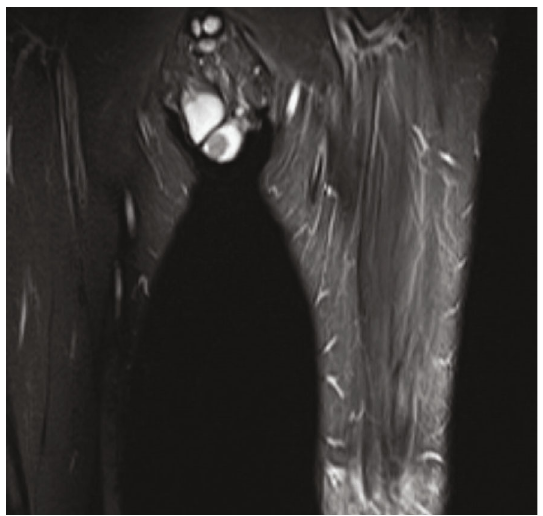
Figure 3: MRI with T2 imaging demonstrating hypointense nodule on the left